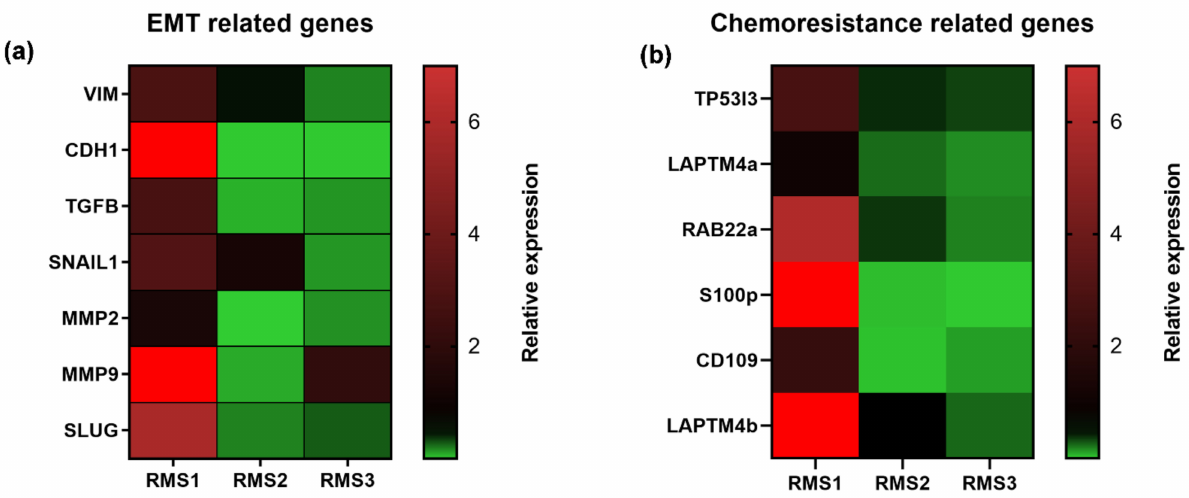
Figure 5. ( a ) Heat map comparison of the relative gene expression of selected EMT-associated genes in RMS tumor tissue compared to matched control tissue; ( b ) Heat map comparison of the relative gene expression of selected chemoresistance- associated genes in RMS tumor tissue compared to matched control